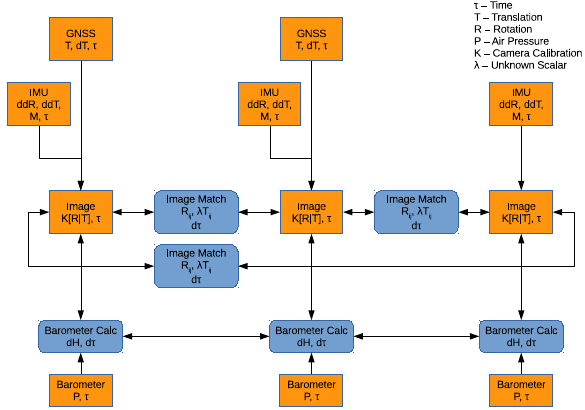
Figure 1: Illustration of a section of a graph generated using our technique. Function nodes in blue and sensor measurement nodes in